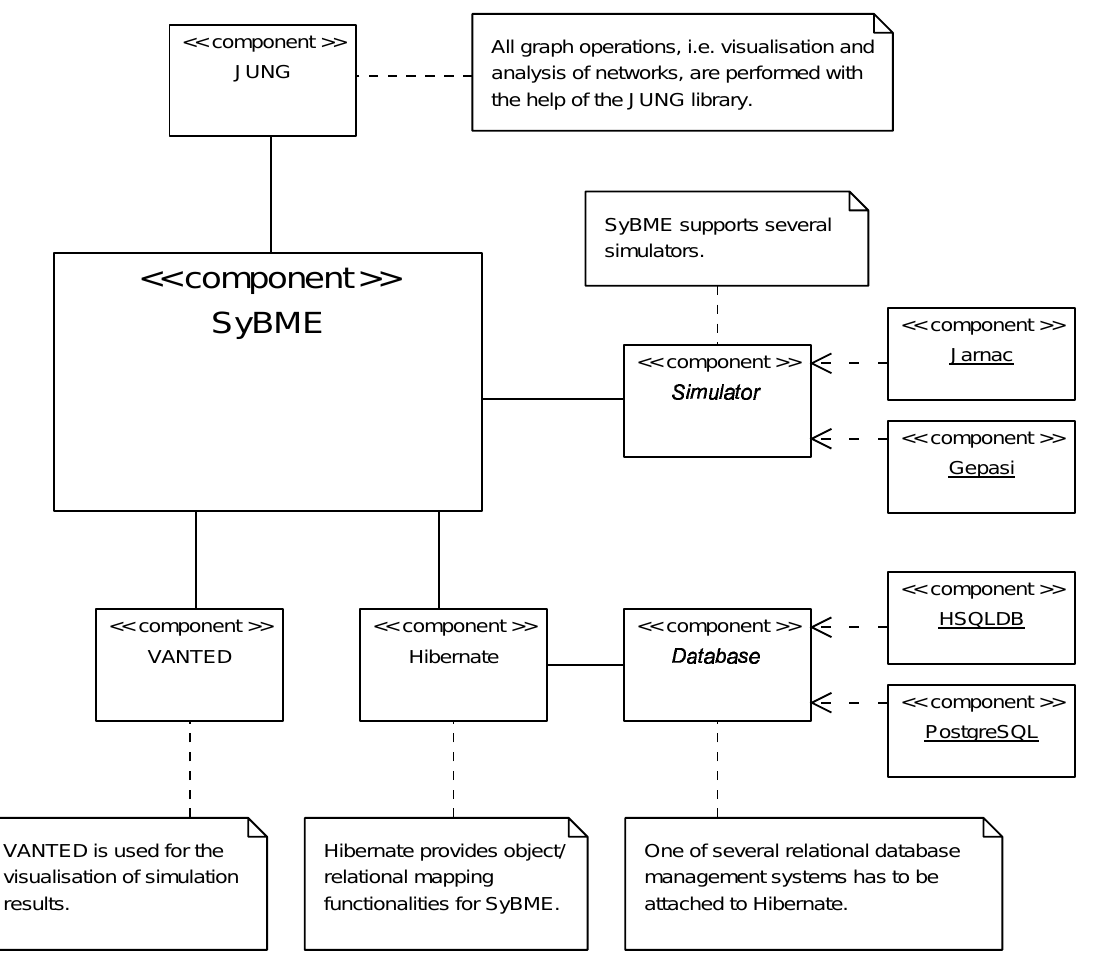
Figure 1: The architecture of SyBME shown as a UML component diagram. Components that are integrated into SyBME are attached with solid lines. Components connected with dashed arrows are required but interchangeable, e.g. only one of the database management systems is required. A dashed line connects a note to the corresponding